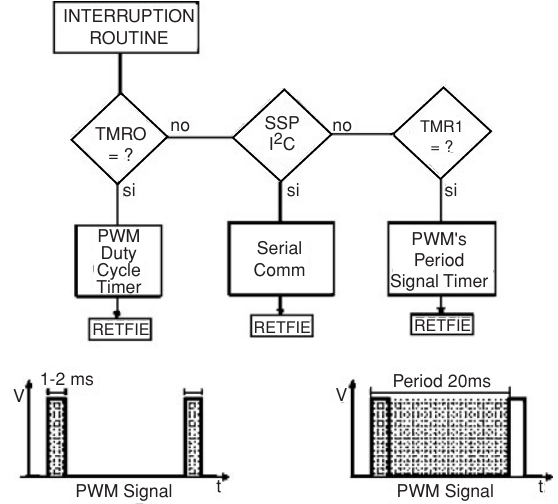
the variable offset or initial position sent to each segment from the master. Thus, a vertical sine wave movement can be generated along the platform. All the segments receive a triangle signal for the vertical servo’s movement sequence. In the rectilinear gait, each segment sends a triangle signal to the vertical servo and a steady center signal to all the horizontal servos. As explained before, the master sends to each servo the initial position. In this sequence the initial position of each segment is: segment no. 1, center; segment no. 2, high limit; segment no. 3, center; segment no. 4, low limit; and segment no. 5, center. Different amplitudes are manipulated varying the vertical servo position from a 0 ◦ to a 180 ◦ range divided 183 C (cid:1) Woodhead Publishing Ltd